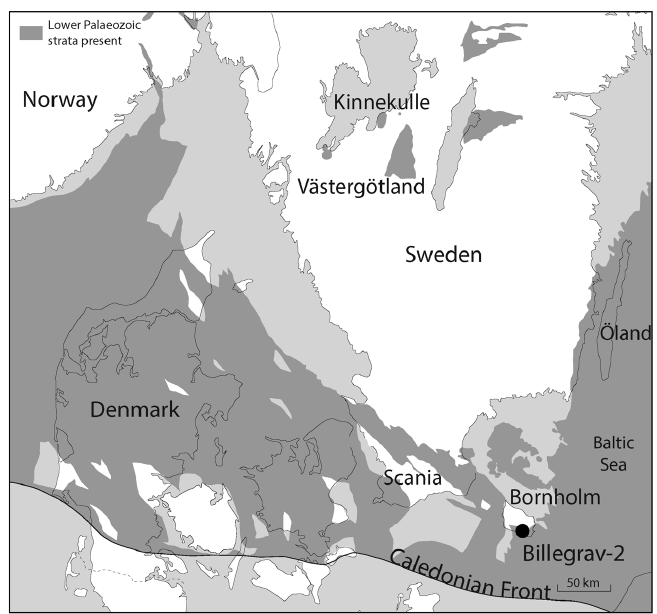
Fig. 1. Location of the Billegrav-2 drilling site and distribution of Lower Palaeozoic sediments in southern Scandinavia. Modified from Nielsen & Schovsbo